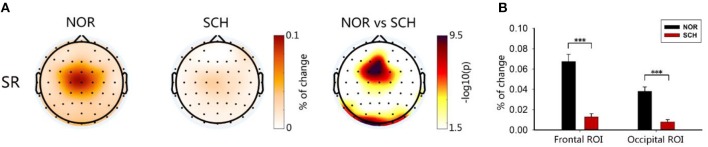
Brain topographic map and ROIs. In (A), the first two plots represent the suppression ratios, and the darker the color was, the greater the suppression ratio would be. The third plot was the result of the two-sample t-test. The logarithm was taken, and the darker the color was, the greater the difference would be. Panel (B) shows the ROI histogram, including the frontal ROI and occipital ROI. Black and red represent the suppression ratios of the controls and patients, respectively. ***Less than the significance p-value of 0.001.